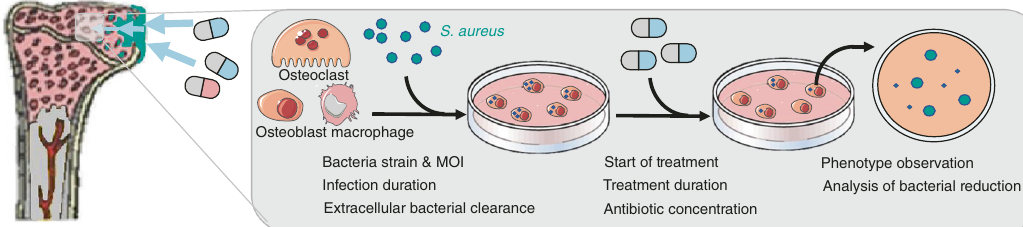
Fig. 2 Overview of the methodology of intracellular infection